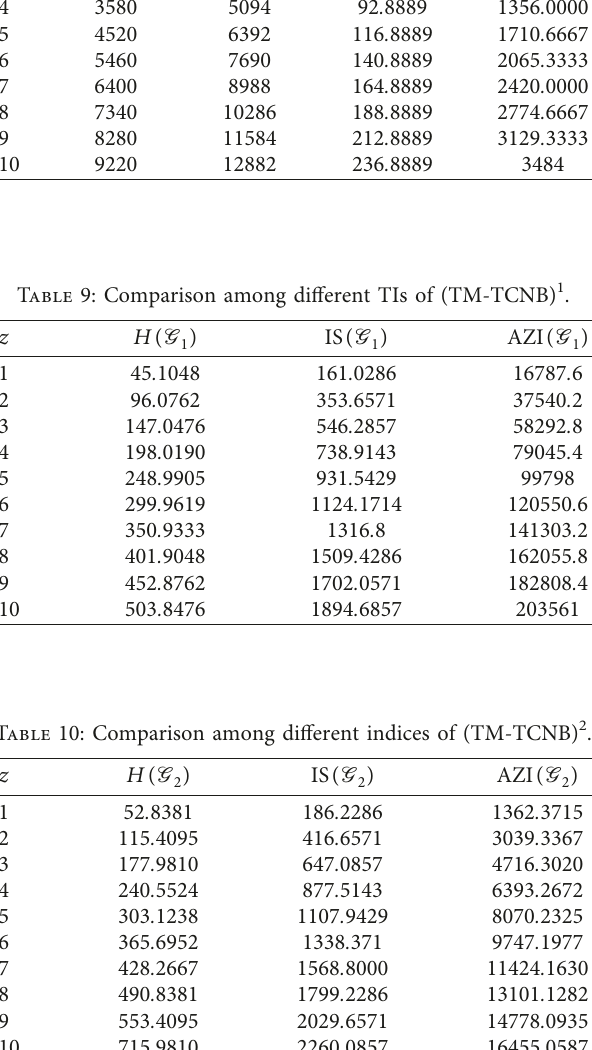
Figure 6: Comparison among different TIs of (TM-TCNB) 1